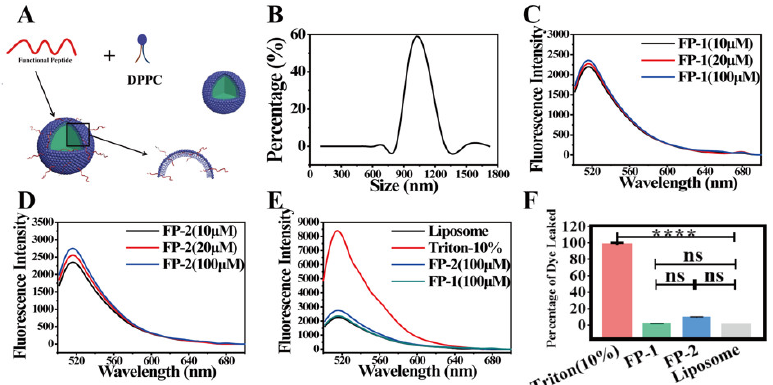
Figure 2. The interaction between the functional peptides of SARS-CoV-2 and DPPC liposomes. ( A ) Schematic diagram of the functional peptides interacting with DPPC liposomes. ( B ) Particle-size distribution of DPPC liposomes. ( C , D ) Dye-release assay of calcein-encapsulated DPPC liposomes induced by FP-1 and FP-2 (10 μΜ, 20 μΜ, 100 μΜ). ( E ) Dye-release assay of calcein-encapsulated DPPC liposomes induced by FP-1 and FP-2 (100 μΜ). Triton (10%) is the positive control. PBS is the negative control. ( F ) Percentage of dye leakage of each tested group. One-way analysis of variance (ANOVA) with Bonferroni’s correction, not significant (n.s.), **** p < 0.0001, error bars are standard deviation, s.d.